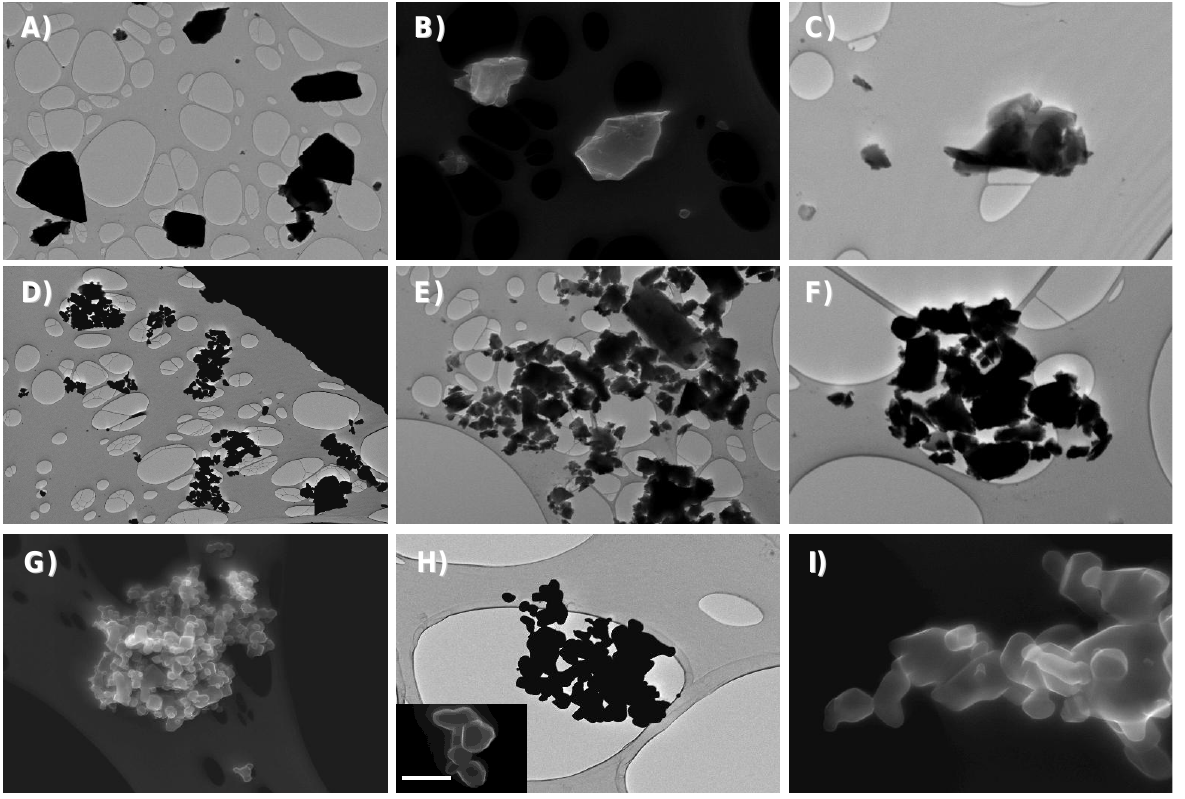
FIGURE 2. SEM and STEM images of particles from stock solutions prepared in the same manner as those used for i.t. instillations. The scale bar for images in each column is shown in last row (P–R), except where otherwise indicated. (A) STEM image of SRM1878a showing large angular quartz particles and smaller agglomerates. In general, the particles can be seen as dark angular agglomerates or single particles, as opposed to the ellipsoid grid holes. (B) SEM image showing the angular morphology of SRM1878a. (C) STEM image showing the presence of smaller agglomerates/aggregates of quartz in SRM1878a. (D) STEM image of DQ12 showing submicro- to micro- size agglomerates and the individual quartz particles. (E) STEM image showing the open structure of quartz agglomerates in DQ12 as well as the angular morphology of the individual particles. (F) STEM image showing the presence and morphology of smaller particles (<0.5  m) in DQ12. (G) SEM image showing an example of the partially open aggregate structure of a large aggregate in TiO MR. (H) STEM image showing an open aggregate of 2 euhedral and a few subhedral rutile particles in TiO MR. The insert shows a close-up of a small aggregate fused at 2 crystal faces (scale bar 200 nm). (I) SEM image showing euhedral crystals and sub- to anhedral particles fused together in a coarse aggregate in TiO MR. (J) SEM image showing a general overview of micro- and submicro-size 2 rutile aggregates and agglomerates of TiO NR. (K) SEM image showing an apparently dense texture of an 2 aggregate/agglomerate cluster in TiO NR. (L) SEM-image of submicro-size agglomerates, aggregates, and 2 individual rutile crystals in TiO NR. The insert shows the platy or lathlike shape of the individual rutile 2 nanocrystallites (scale bar 200 nm). (M) SEM image showing an agglomerate consisting of several angular and subangular anatase particles in TiO NA. (N) SEM image showing small micro- to submicro-size 2 agglomerates/aggregates of individual angular anatase particles in TiO NA. (O) SEM image showing the rough and 2 highly irregular surfaces of the anatase particles in TiO NA. (P) SEM image of agglomerated particles in TiO NAM. 2 2 (Q) SEM image showing angular to subangular single particles in the nano-size range to a >2-  m aggregate of particles in TiO NAM. (R) SEM image showing the rough surface of TiO particles in TiO 2 2 2